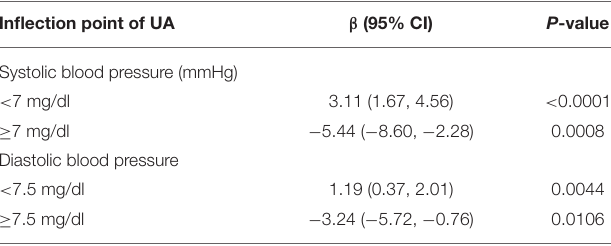
TABLE 3 | Threshold effect analysis of UA on SBP and DBP using piecewise linear regression in the hypertension non-treatment